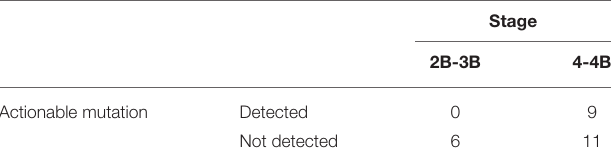
TABLE 5 | Cancer stage-dependence of detection of actionable mutations in